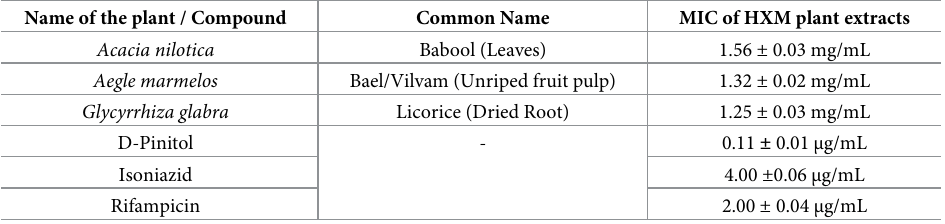
Table 2. MIC of HXM plant